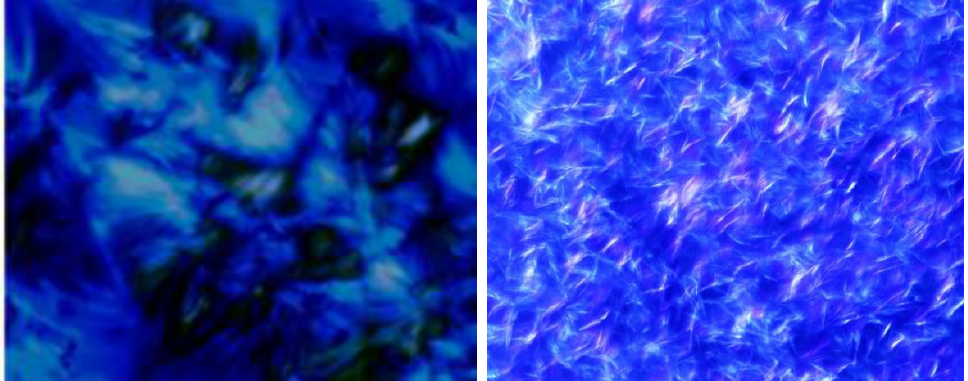
Figure 7. Wax crystals in saturated hydrocarbon without ( left ) and with flow improver ( right ).